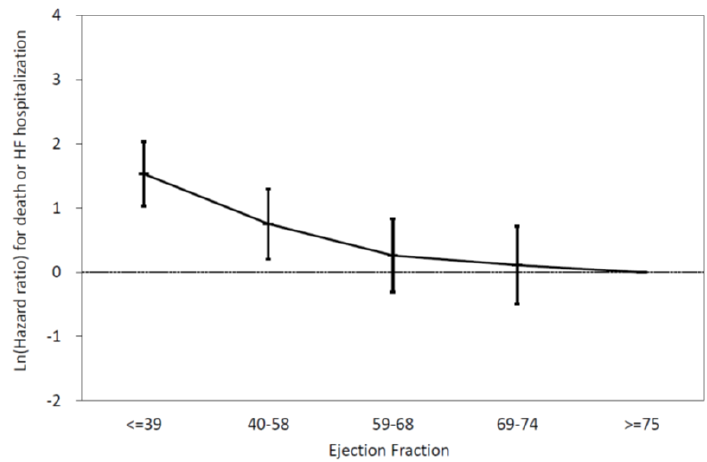
Figure 2. The relationship between LVEF and CV outcomes in all patients. This relationship was not linear. The lower LVEF subgroup (LVEF ≤ 39%) was associated with a significantly increased risk of CV mortality or HF hospitalization relative to the LVEF ≥ 75% subgroup. ( p = 0.002). LVEF: left ventricular ejection fraction; CV: cardiovascular; HF: heart failure.